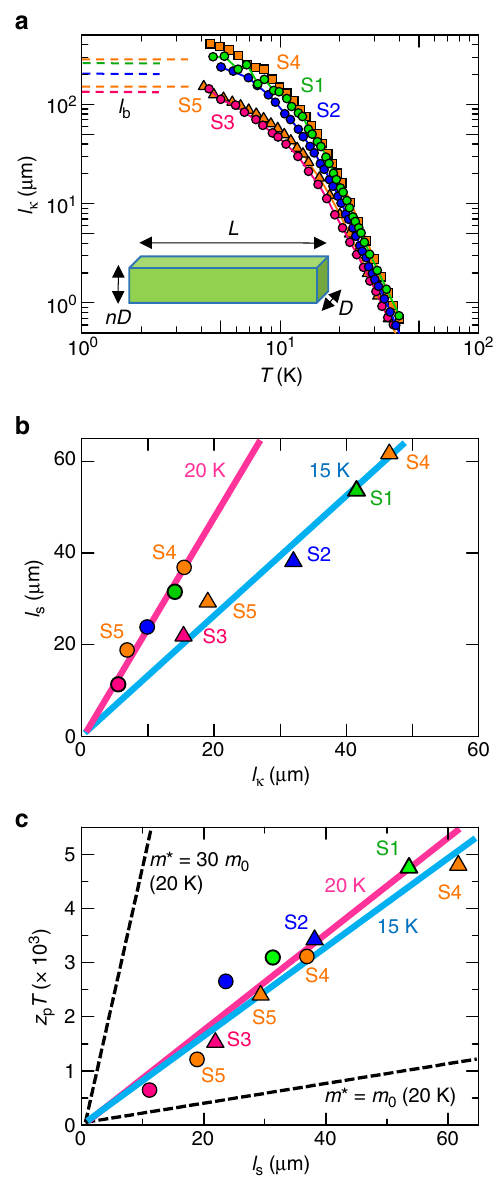
Figure 3 | Phonon MFP and thermoelectric figure of merit for the phonon-drag effect. ( a ) Temperature dependence of the phonon MFP, l k , evaluated from the thermal conductivity with Fourier’s law. Broken lines are phonon MFP values ( l b described by the equation (1)) evaluated by considering scattering at crystal boundaries 29 . Inset shows the sample shape with length scales used for equation (1). ( b ) Comparison of thermal ( l k ) and phonon-drag ( l s ) phonon MFPs at 15K (triangles) and 20K (circles) 9 . ( c ) Phonon-drag dimensionless figure of merit z p T with respect to l s at 15K (blue line) and 20K (red line). z p T also depends on the electron effective mass m * as shown by the broken